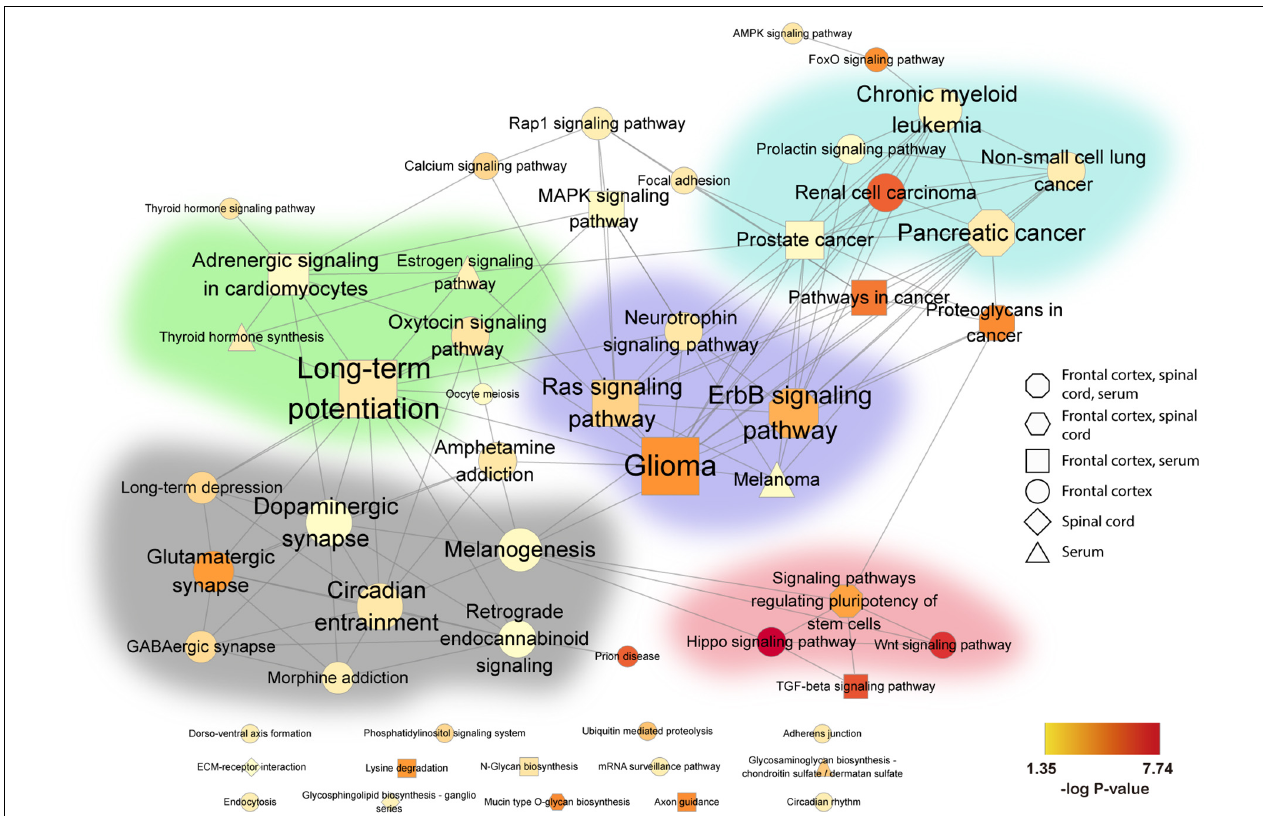
FIGURE 4 | Association network of pathways in human ALS from frontal cortex, spinal cord, and serum. Significantly enriched KEGG pathways were combined and visualized in a network. KEGG pathways are represented by nodes, and shared gene content between pathways are represented by edges. Node shape indicates the tissue source of the enriched pathways: octagon (frontal cortex, spinal cord, serum), hexagon (frontal cortex, spinal cord), square (frontal cortex, serum), circle (frontal cortex), diamond (spinal cord), and triangle (serum). The size of each node denotes the number of miRNAs in that pathway, while the color gradient represents –log 10 ( P- value) (see color scale, yellow to red). All networks were organized by the Edge-weighted Spring Embedded layout in Cytoscape with minimal manual node rearrangement for visibility. Background colors delimit highly inter-connected subnetworks identified by the Cytoscape MCODE app (Bader and Hogue, 2003): green (brain function), gray (neurotransmitter systems), purple (intracellular signaling cascades), blue (cancer related), and pink (stem cell renewal). Non-clustered pathways are arranged at the bottom. FC, frontal cortex; SC, spinal